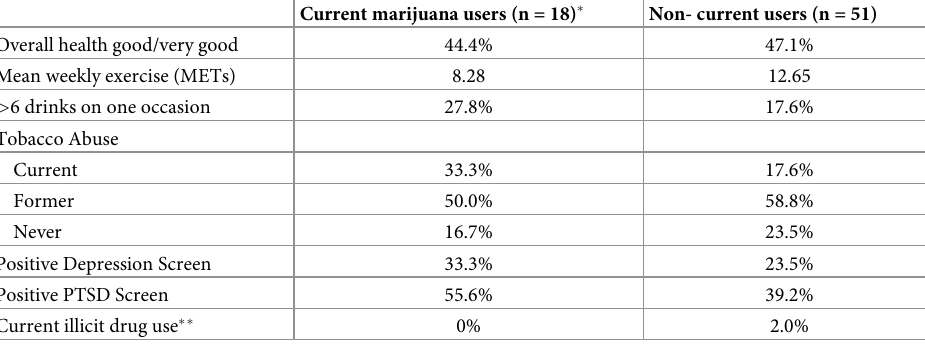
Table 2. Baseline characteristics of